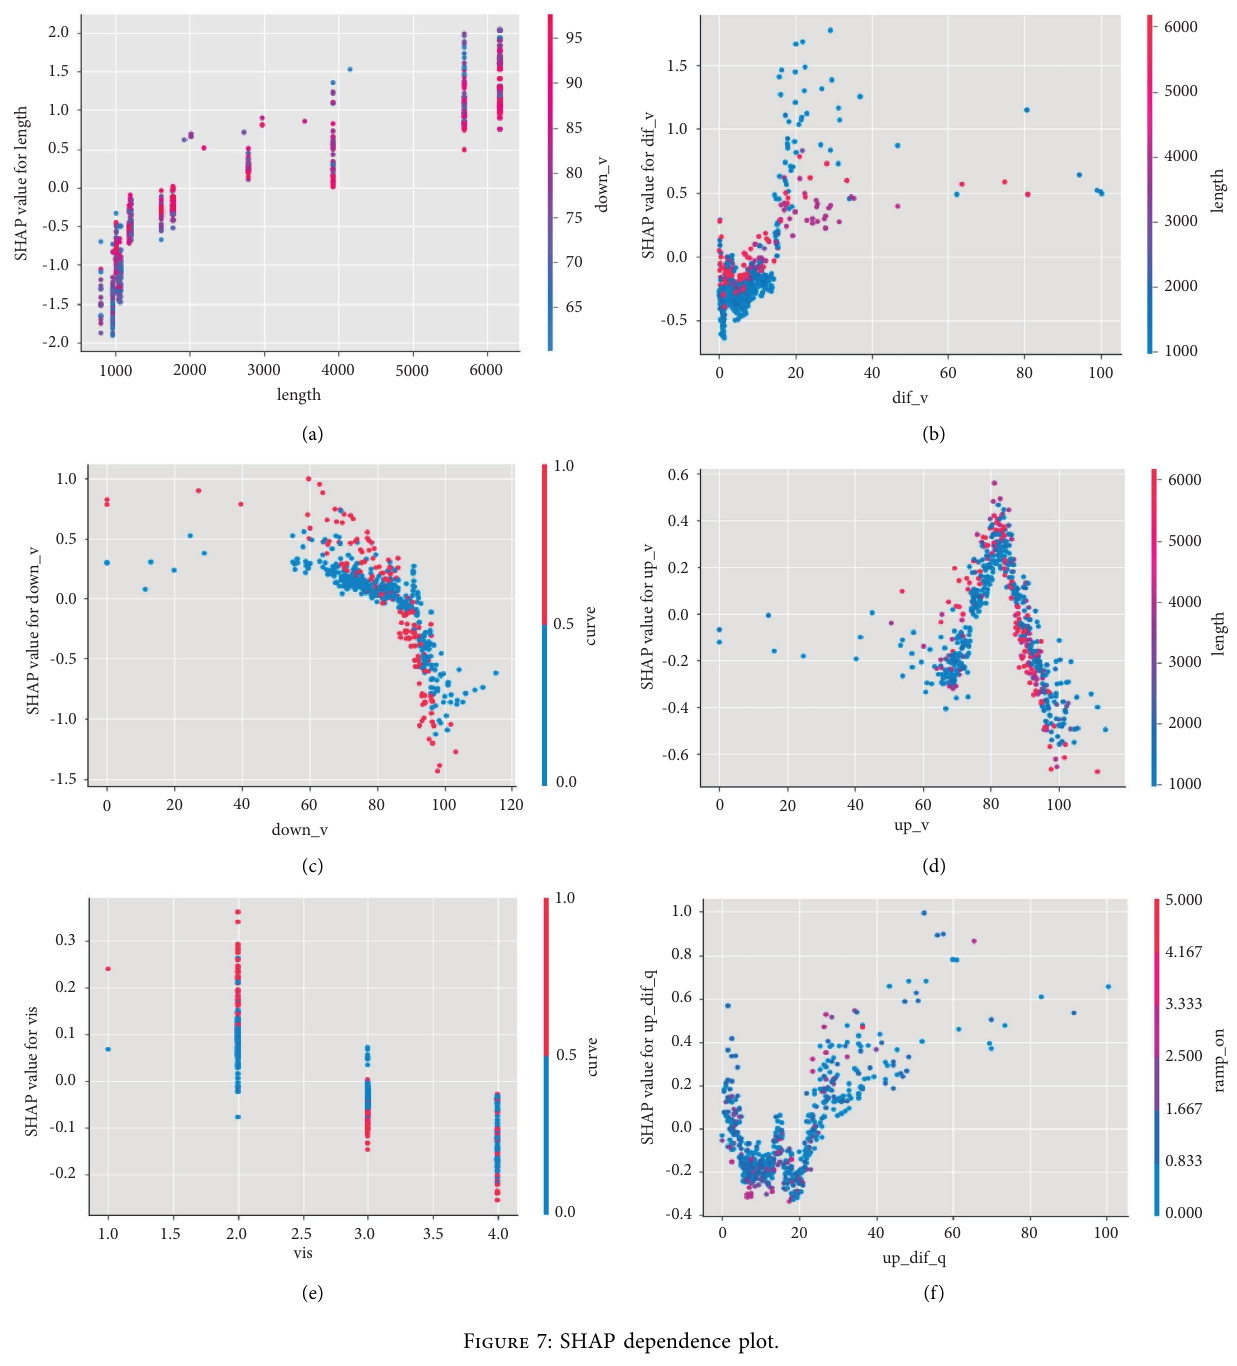
Figure 7: SHAP dependence